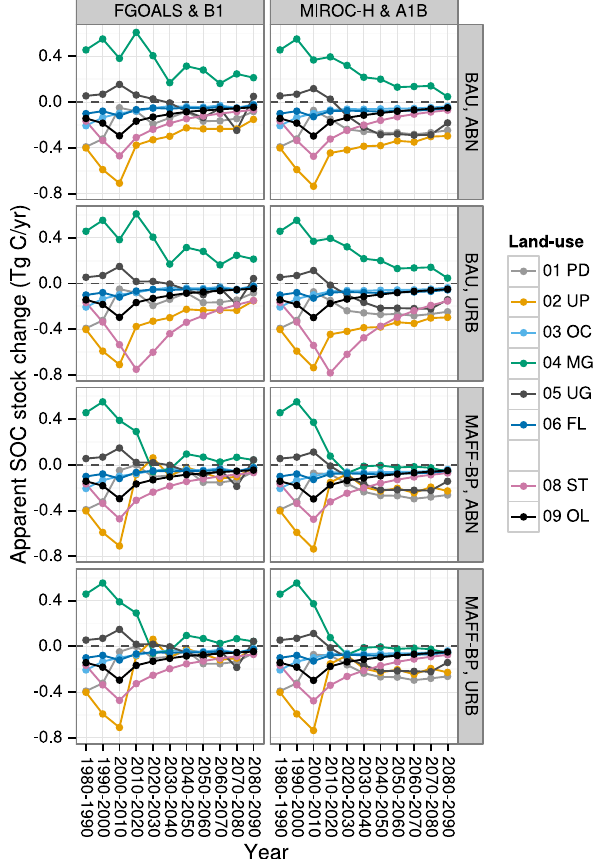
Figure 7. Rate of apparent soil organic carbon (SOC) stock changes in different land-use types under different future climate projections (FGOALS & B1 and MIROC-H & A1B; lined-up horizontally) and combinations of future agricultural activity scenarios (BAU and MAFF-BP) and future land-use change scenarios (ABN – abandon- ment, URB – urbanization) (lined-up vertically). Lines in different colour indicate different land-use types: PD – paddy fields, CL – upland crop fields, OC – orchards, MG – managed grasslands, FL – forest lands, WL – wetlands, ST – settlements, OL – other lands. Positive and negative values on vertical axis indicates gain and loss of SOC stock, which are equivalent to CO 2 removal from and emis- sion to the atmosphere,